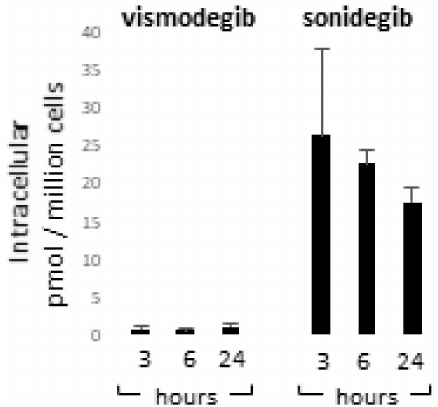
Figure 8. Quantification of vismodegib and sonidegib uptake. Intracellular concentration of vismod- egib and sonidegib was evaluated after 3, 6 and 24 h of drugs exposure. Histograms show mean ± SD of three independent